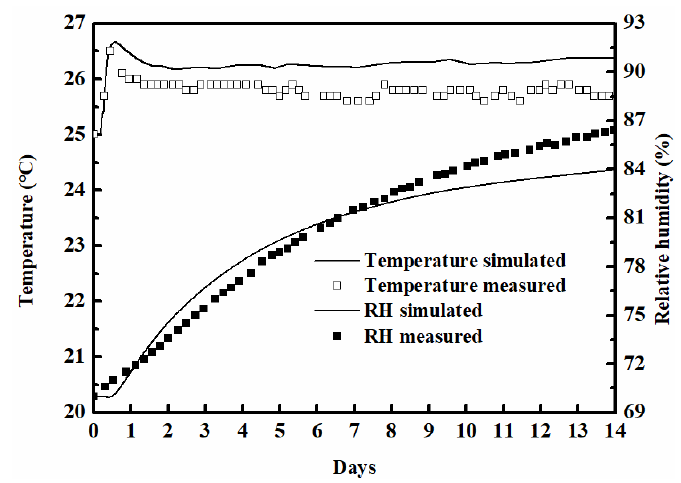
Figure 3. Comparison of simulated temperature and RH with experimental data. Table 2. The physical parameters of wall [38].